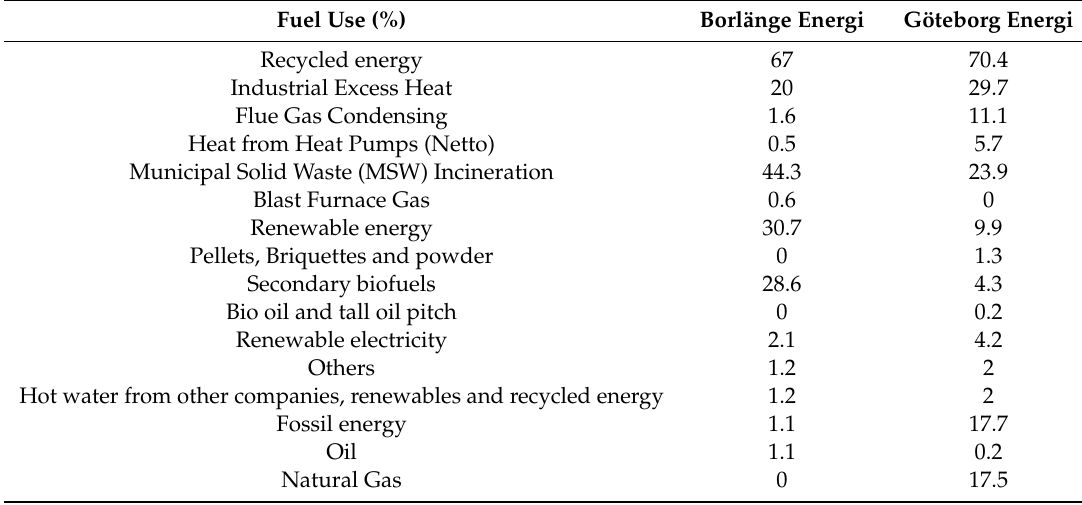
Table 3. Fuel use (%) for district heating